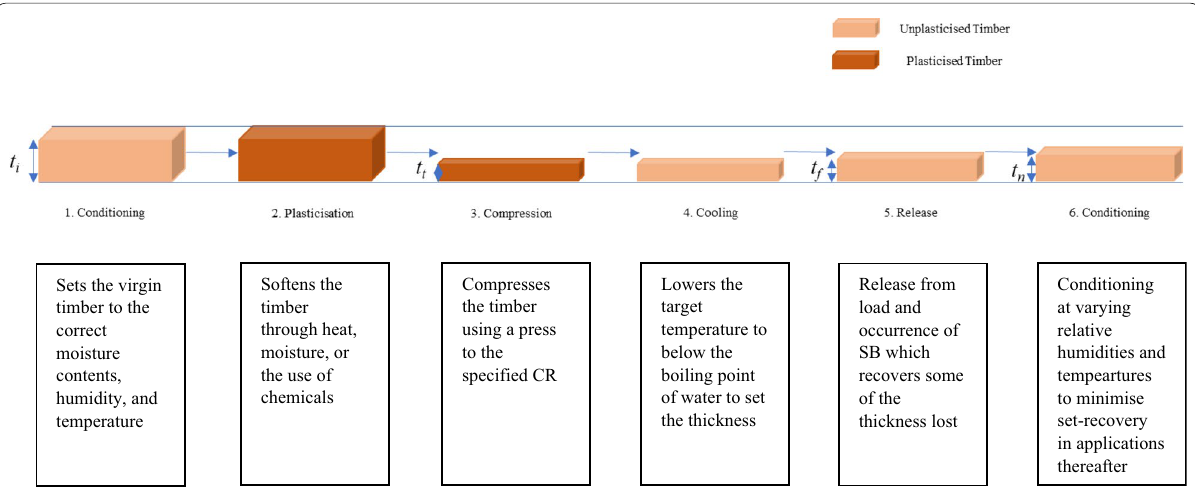
Fig. 4 Schematic showing different stages of